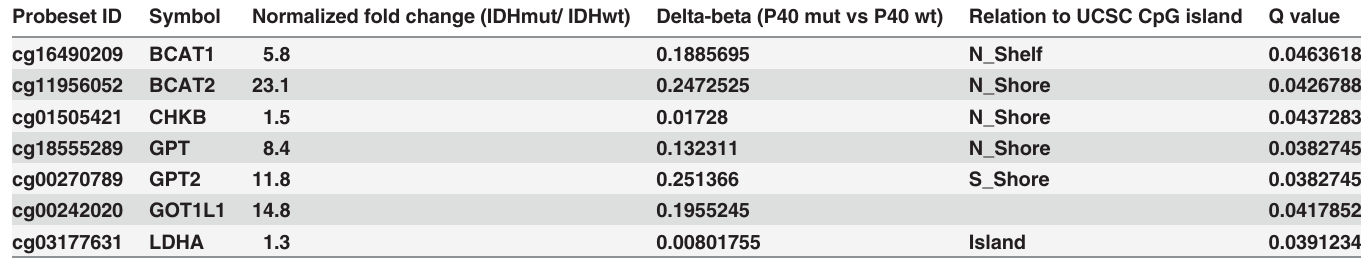
Table 1. The list of differentially methylated genes in mutant IDH1 expressing NHAs was downloaded from the supplementary information provided in the Turcan et al. paper [9] and mined for genes associated with the metabolites identi fi ed to be altered in mutant IDH1 cells in our